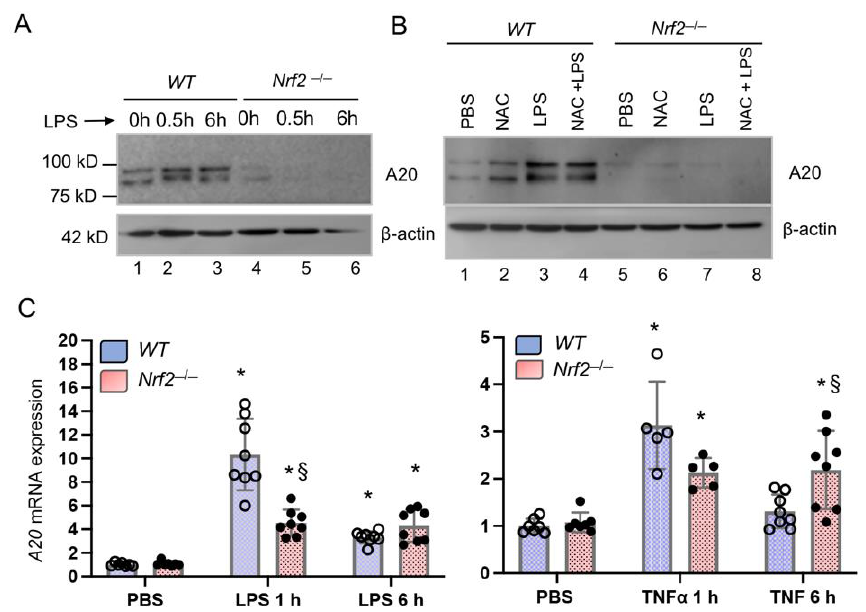
Figure 1. LPS-induced A20 expression is lower in Nrf2-deficient BMDM Φ s. ( A ) Cell extracts were isolated from wildtype (WT) and Nrf2 − / − bone marrow-derived macrophages (BMDM Φ s) treated with LPS (100 ng/mL), blotted and probed with A20 antibodies. ( B ) WT and Nrf2 − / − BMDM Φ s were treated with 5 mM N-acetylcysteine (NAC) for 16 h and then treated with LPS for 1 h. Cell extracts were probed A20 antibodies. Note that blotted membranes were cut at ~50 kD and top and bottom portion of the blots were probed with A20 and β -actin antibodies, respectively. ( C ) WT and Nrf2 − / − BMDM Φ s isolated from male and female mice in separate experiments were treated with LPS (100 ng/mL) or TNF α (10 ng/mL) for 1 h or 6 h. Total RNA was isolated for A20 mRNA expression analysis. Values of PBS controls used in right panel are the same as those in left panel. * versus PBS; § versus WT counterparts. LPS and TNF α stimulated A20 mRNA expression levels in BMDM Φ s of male and female mice are shown in Figure S1.